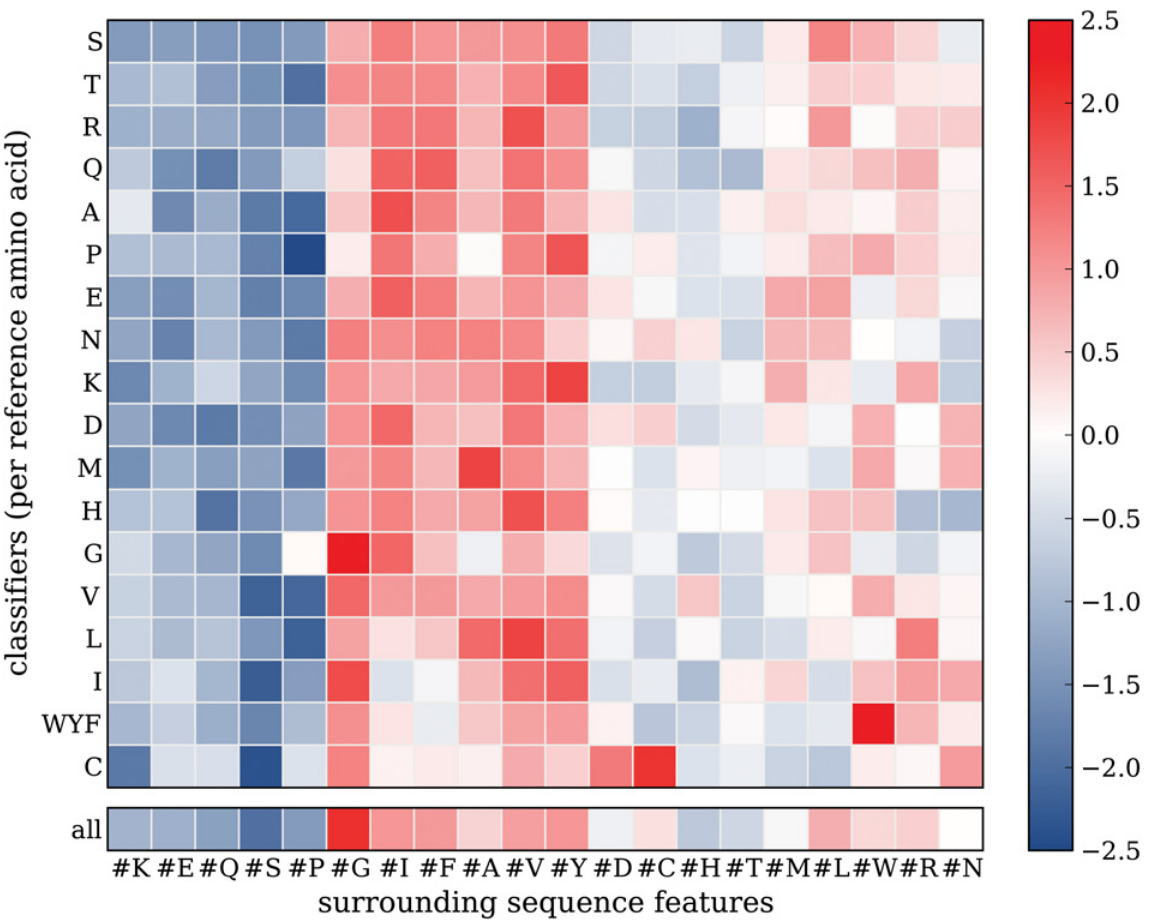
Fig 4. Surrounding sequence feature weights. Heat maps showing feature weights obtained from classifiers trained using the surrounding sequence features. The rows show feature weights obtained per variant subset classifier. Both the rows and the columns are hierarchically clustered (complete linkage). The single row at the bottom shows feature weights obtained from a classifier trained on the entire set of variants. Low (blue) and high (red) weights indicate that the feature is predictive for neutral and disease-associated variants